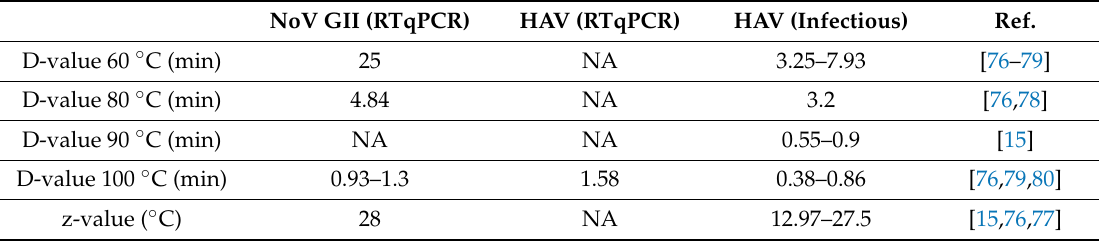
Table 4. Reported D-values (minutes required to achieve a log reduction at the indicated